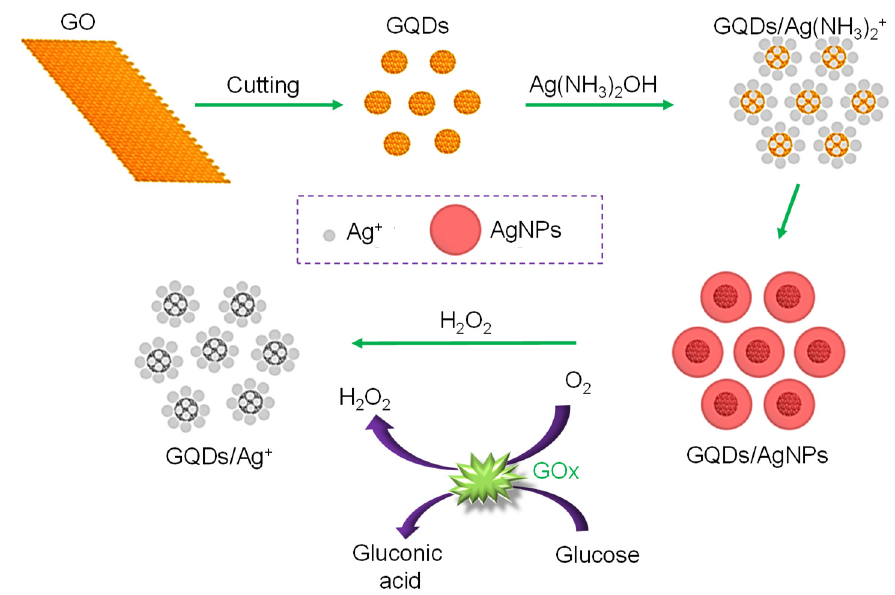
Figure 32. Preparation of GQDs / AgNPs nanocomposite for colorimetric detection of H 2 O 2 and glucose. Adapted from Chen et al. [369].